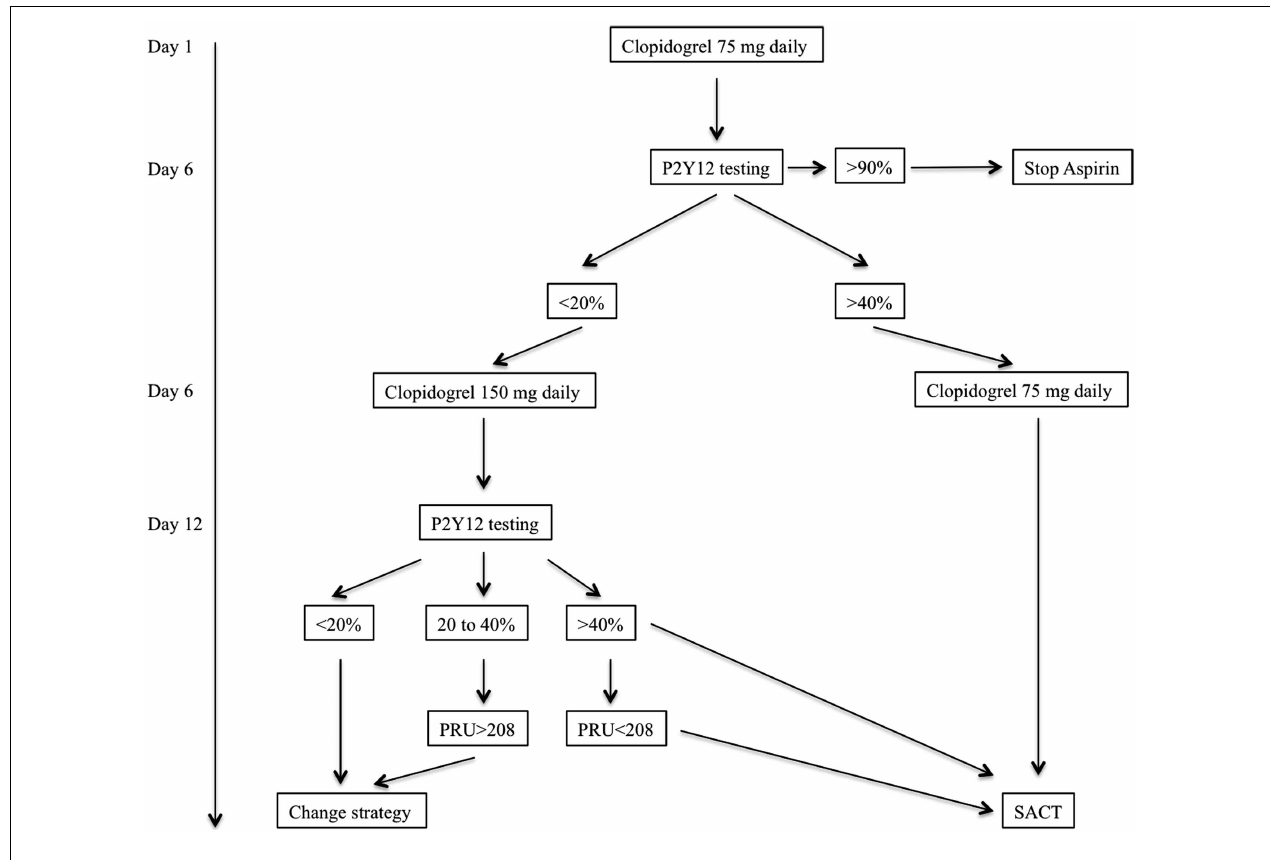
prodrug treatment should be initiated 5–6days before efficacy assessment. PRU, platelet reaction unit; SACT, stent-assisted coiling